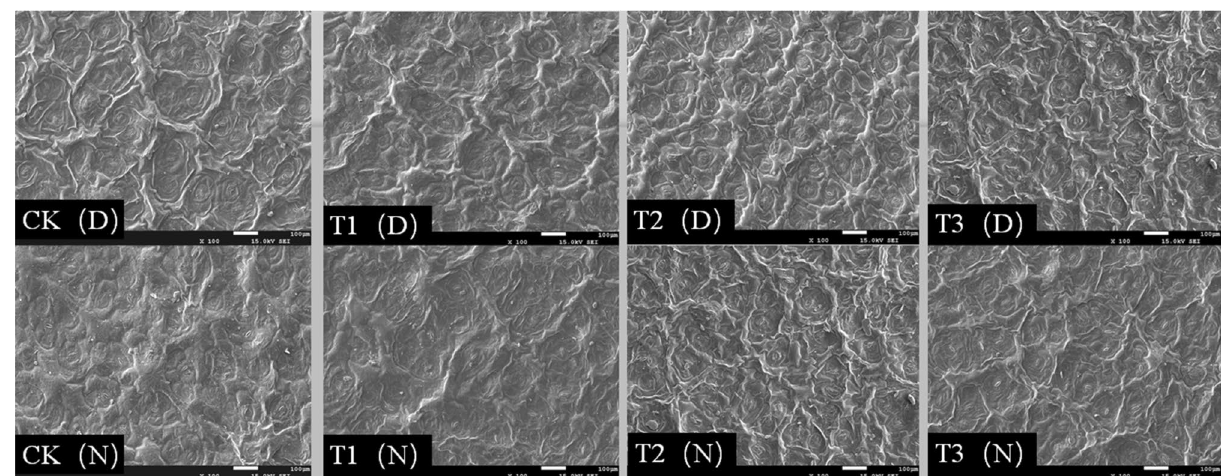
Figure 7. Scanning electron micrographs of Phedimus aizoon L. leaves under drought stress (×